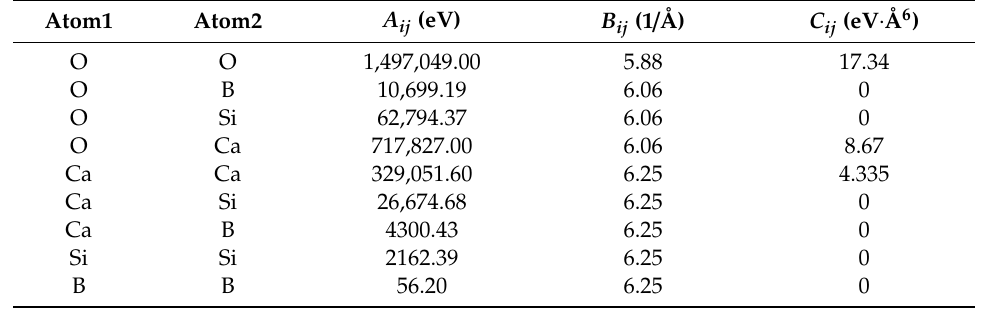
Table 1. Born-Mayer-Huggins (BMH) potential parameters of atomic pairs in CaO-SiO 2 -B 2 O 3 melts.